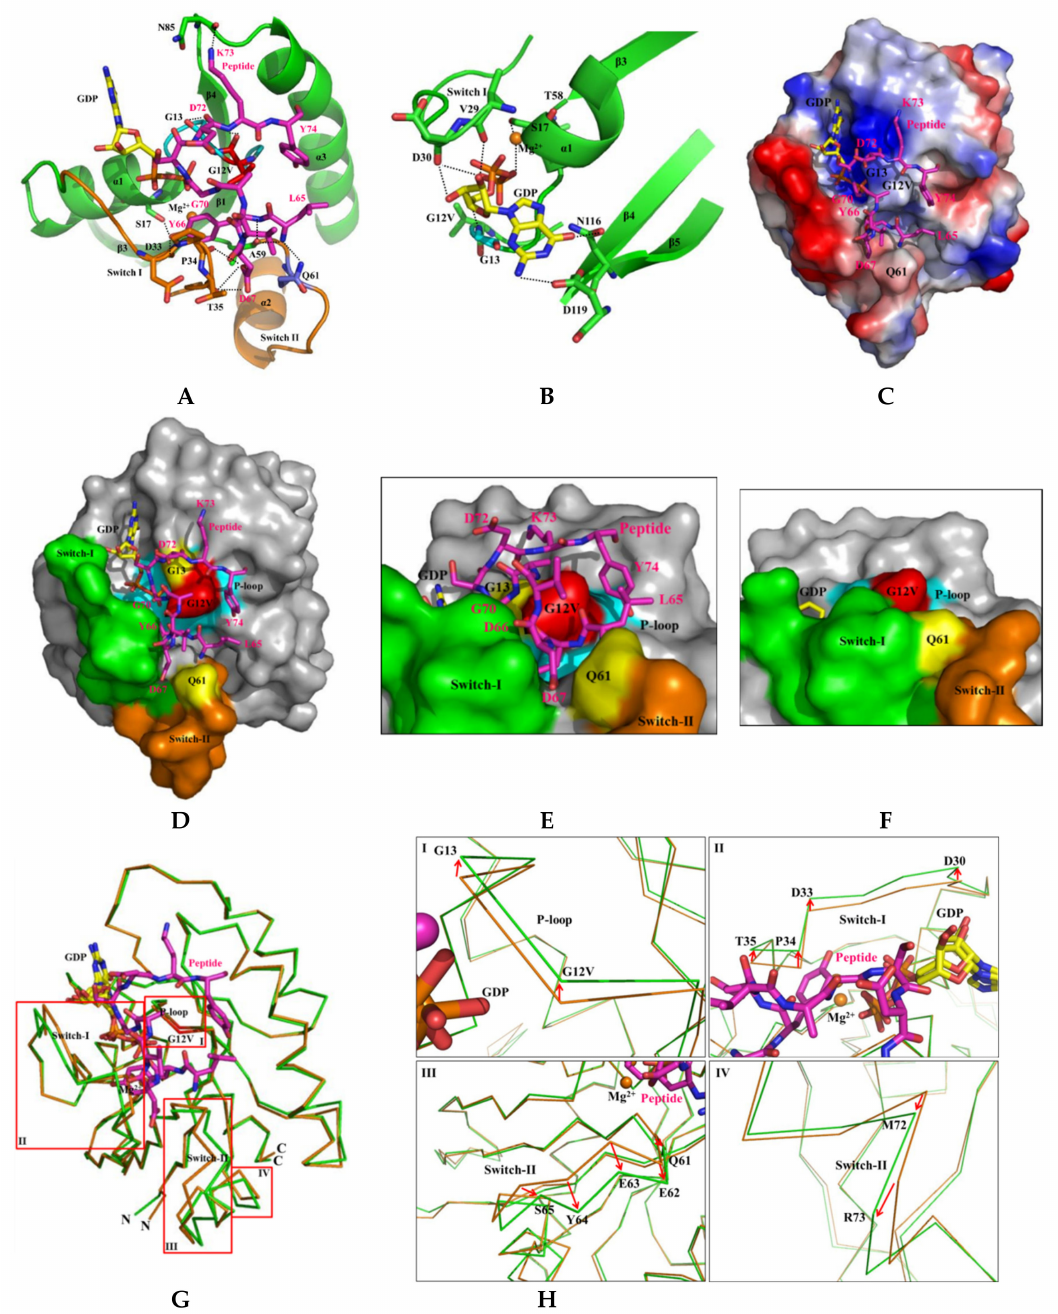
Figure 6. Detailed binding and structural characterization of KRAS G12V and H-REV107 peptide. ( A ) Binding region of the KRAS G12V and H-REV107 peptide is shown. The KRAS G12V, G13, and Q61 residues are coordinated and stabilized by L65, D72, K73, Y74, and MgGDP. The KRAS residues and H-REV107 peptide on the hydrogen-bonding network are labeled. ( B ) Interaction of the MgGDP and KRAS G12V-H-REV107 peptide is shown. MgGDP bound to residues of the P-loop, and switch I and II regions and NKXD motif of the KRAS G12V. ( C ) The relative distribution of the surface charge of the KRAS-H-REV107 is shown with the acidic region in red, the basic region in blue, and the neutral region in white. ( D , E ) Surface representations of the KRAS G12V-H-REV107 peptide complex are shown from the front and top sides. G12V (red), G13 and Q61 (yellow), switch I (green) and II (orange) regions, P-loop (blue), and peptide (purple) are shown. Peptide D67 deeply penetrated into the hole between the switch I and II pockets. ( F ) Surface representation of the KRAS G12V · MgGDP is